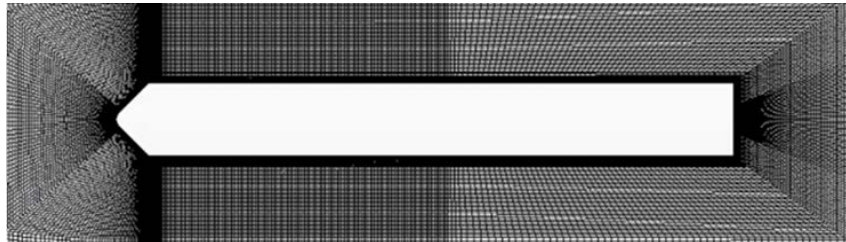
Figure 3. ( a ) Position of the monitoring surface in the two-dimensional calculation domain; ( b ) rear view of the monitoring surface. Figure 4. Mesh generation around the